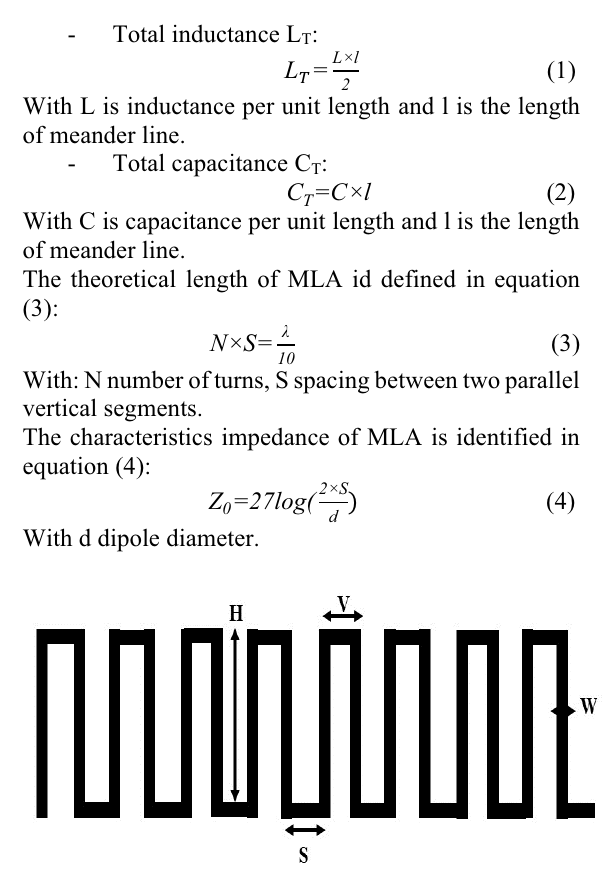
Fig.2. Meander line antenna structure.